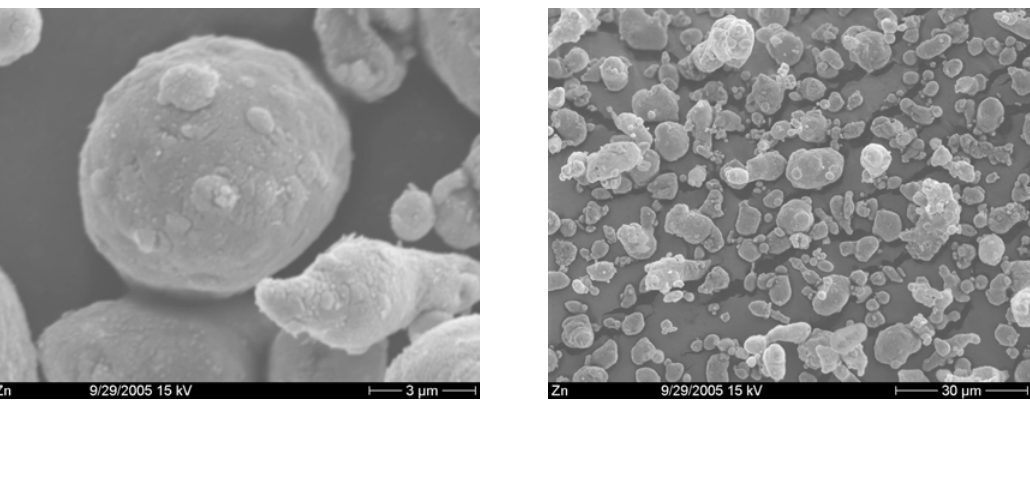
Figure 3. Zn powder,